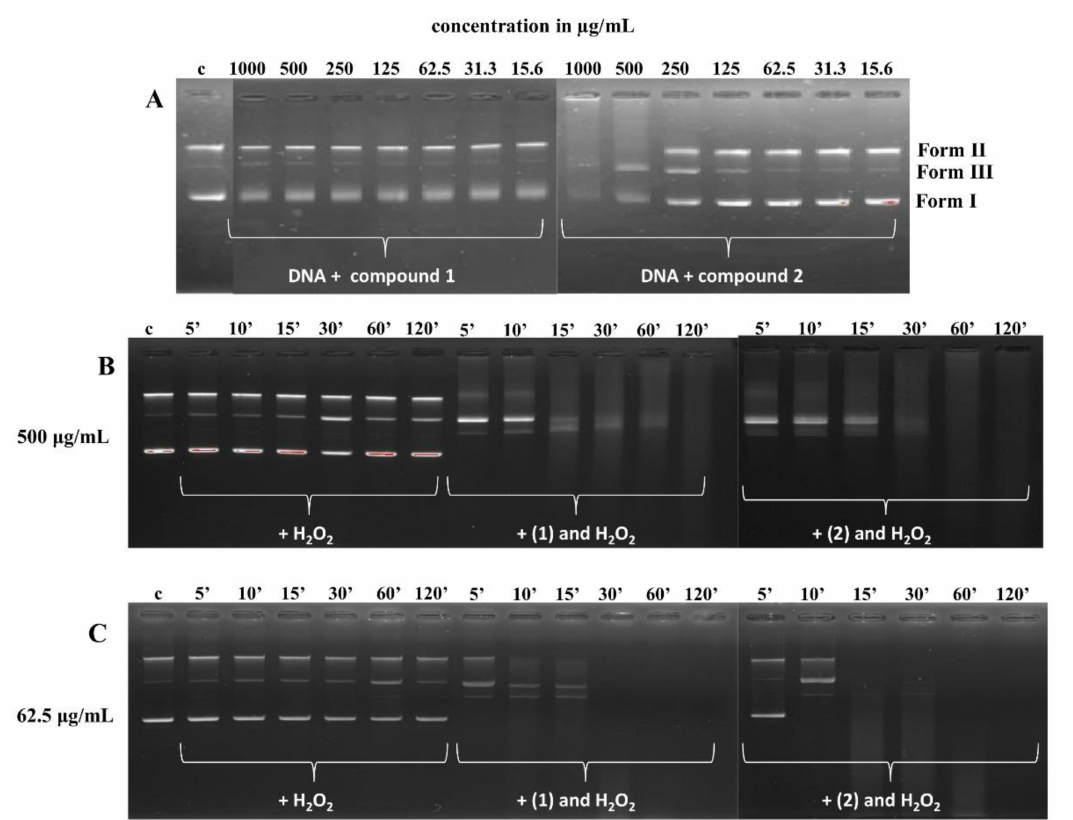
Figure 8. The cleavage of supercoiled pBR322 DNA (62.5 µ g/mL) by the complexes at 37 ◦ C in 5 mM Tris HCl, 50 mM NaCl buffer. ( A )—DNA incubated with compounds ( 1 ) and ( 2 ), respectively; c, control line—DNA in buffer (5 mM Tris HCl, 50 mM NaCl) (1:1), 1000–15.6 µ g/mL, decreasing concentration of compounds ( 1 ) and ( 2 ). ( B )—DNA incubated with H 2 O 2 (100 µ M), compound (1) (500 µ g/mL) + H 2 O 2 (100 µ M), and ( 2 ) (500 µ g/mL) + H 2 O 2 (100 µ M), respectively; c, control line—DNA in buffer (5 mM Tris HCl, 50 mM NaCl) (1:1), 5–120 min, time of incubation. ( C )—DNA incubated with H 2 O 2 (100 µ M), compound ( 1 ) (62.5 µ g/mL) + H 2 O 2 (100 µ M) and ( 2 ) (62.5 µ g/mL) + H 2 O 2 (100 µ M), respectively; c, control line—DNA in buffer (5 mM Tris HCl, 50 mM NaCl) (1:1), 5–120 min, time of